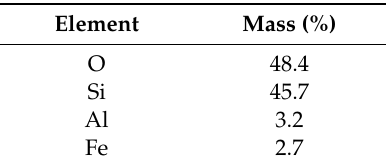
Table 7. Averaged mass percentage concentrations of the major elements in diatomaceous earth (EDS analysis).